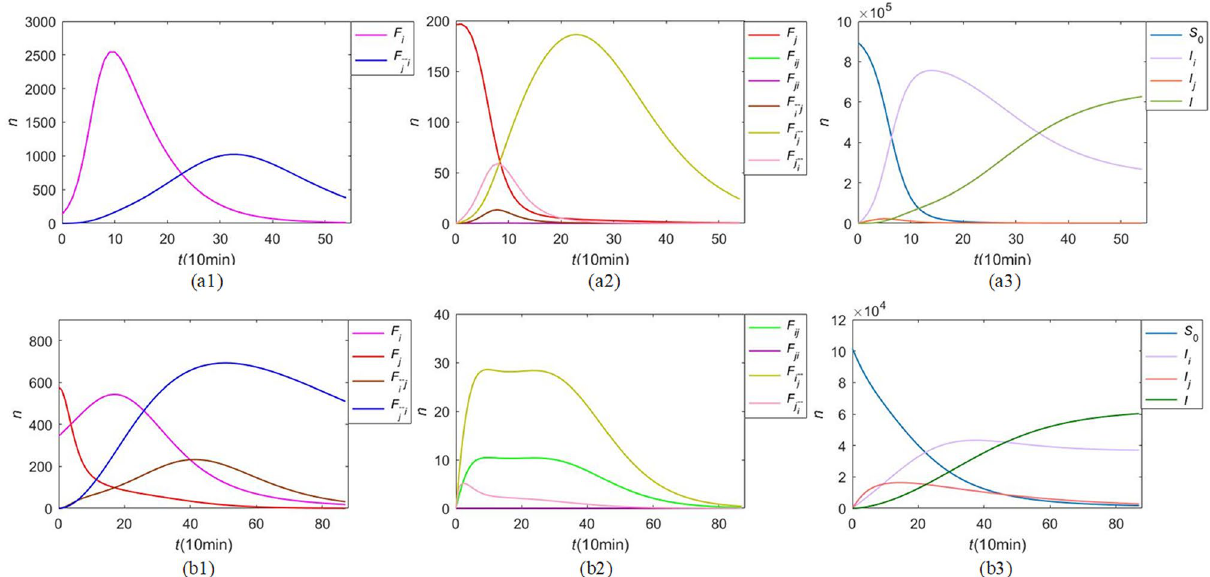
Figure 12. Physical process of CT-SFI model. ( a ) event 1 in Table 2; ( b ) event 2 in Table 3. Where S ( t ), F i ( t ) , F j ( t ) , I i ( t ) , I j ( t ) , F ij ( t ) , F ji ( t ) , F ¯ orders of magnitude of the population are put on the same graph.